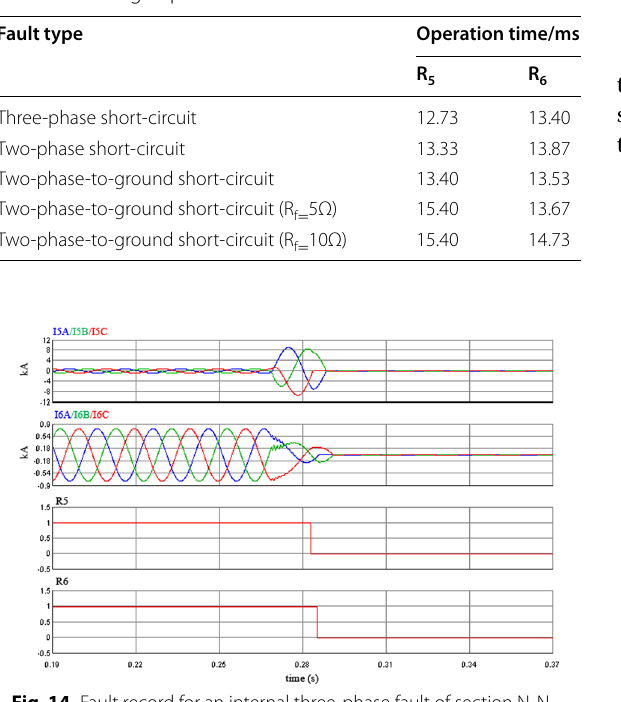
Fig. 15 Fault record for an internal phase A to B fault of section N 3 N